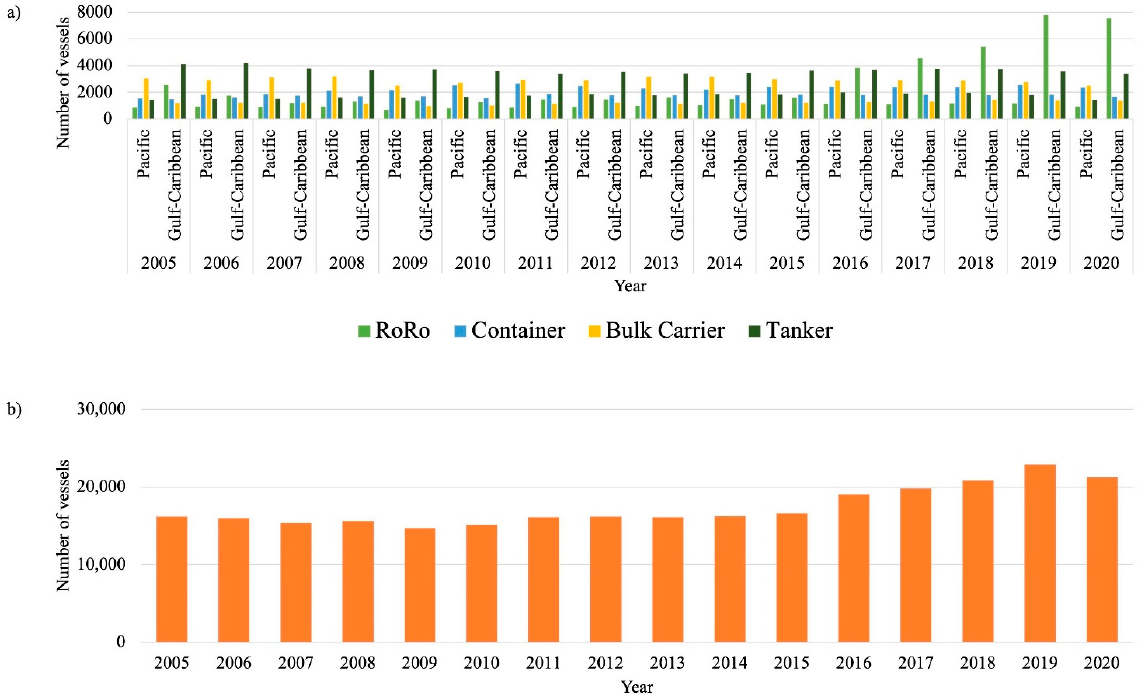
Figure 3. Arrivals by ( a ) type of vessel and ( b ) total vessels from 2005 to